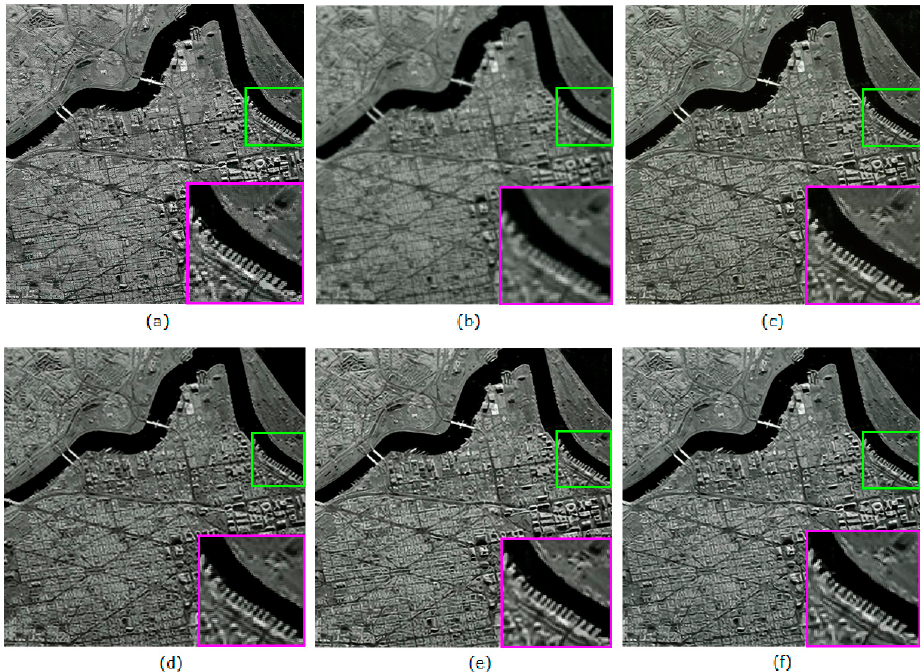
Figure 8. The single-look image and the corresponding multi-look references. ( a ) Grayscale mul- tilook reference; ( b ) Grayscale single-look image; ( c ) Color multi-look reference; ( d ) Color single- look image.